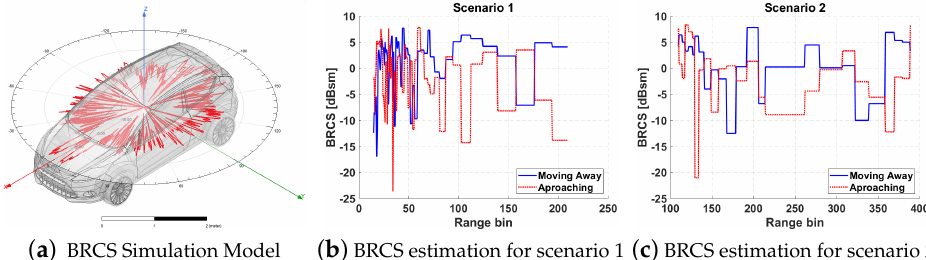
Figure 12. RCS simulation model and estimated BRCS in each range bin for the two trial scenarios in the two possible trajectories along the roads: moving away from the PR or approaching it. The coverage curves from the PR as a function of the target BRCS are shown in Figure 13. For coverage calculation, the sensitivity of the system was calculated from the theoretical Signal-to-Noise Ratio (SNR) required for detecting Swerling I targets with additive white Gaussian noise, and the noise factor of the receiver; propagation losses were also considered. The estimated angular coverage, in which the receiving antenna gain is in the range between the maximum measured and the one at the beamwidth edges ( G max -3 dB) is marked in Figure 11.